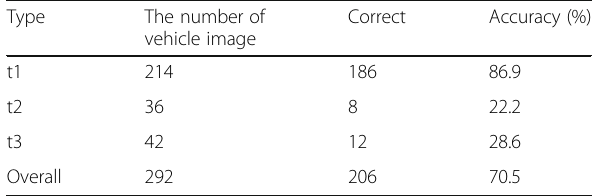
Table 8 Accuracy of vehicle classification by the thermal